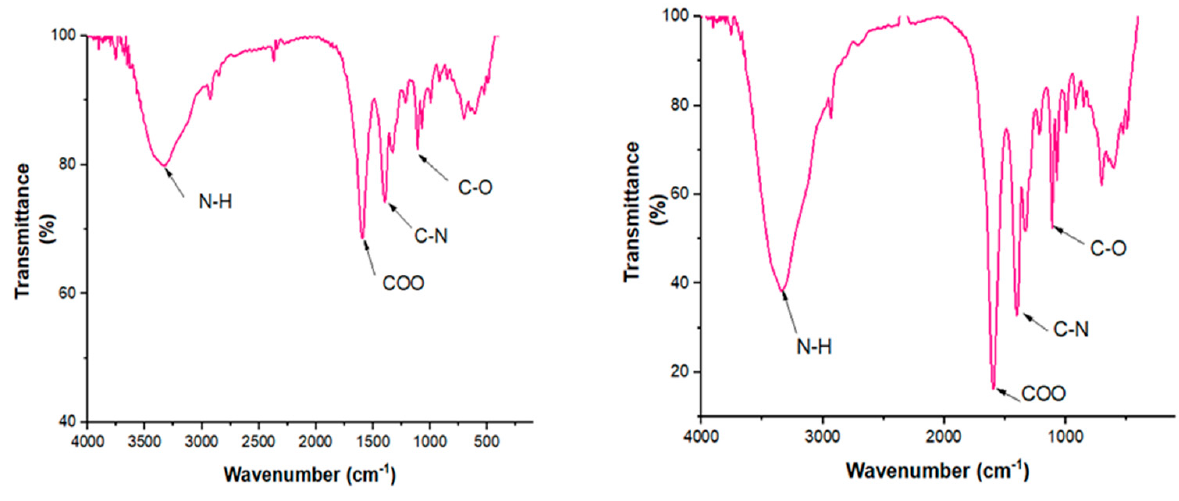
Figure 3. FTIR spectra of aqueous and 70% methanol extract of C. papaya leaf silver synthesized nanoparticles.